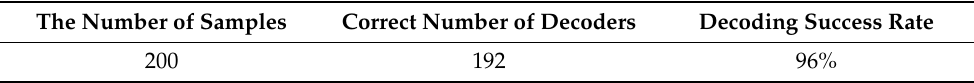
Table 7. Barcode decoding test results.